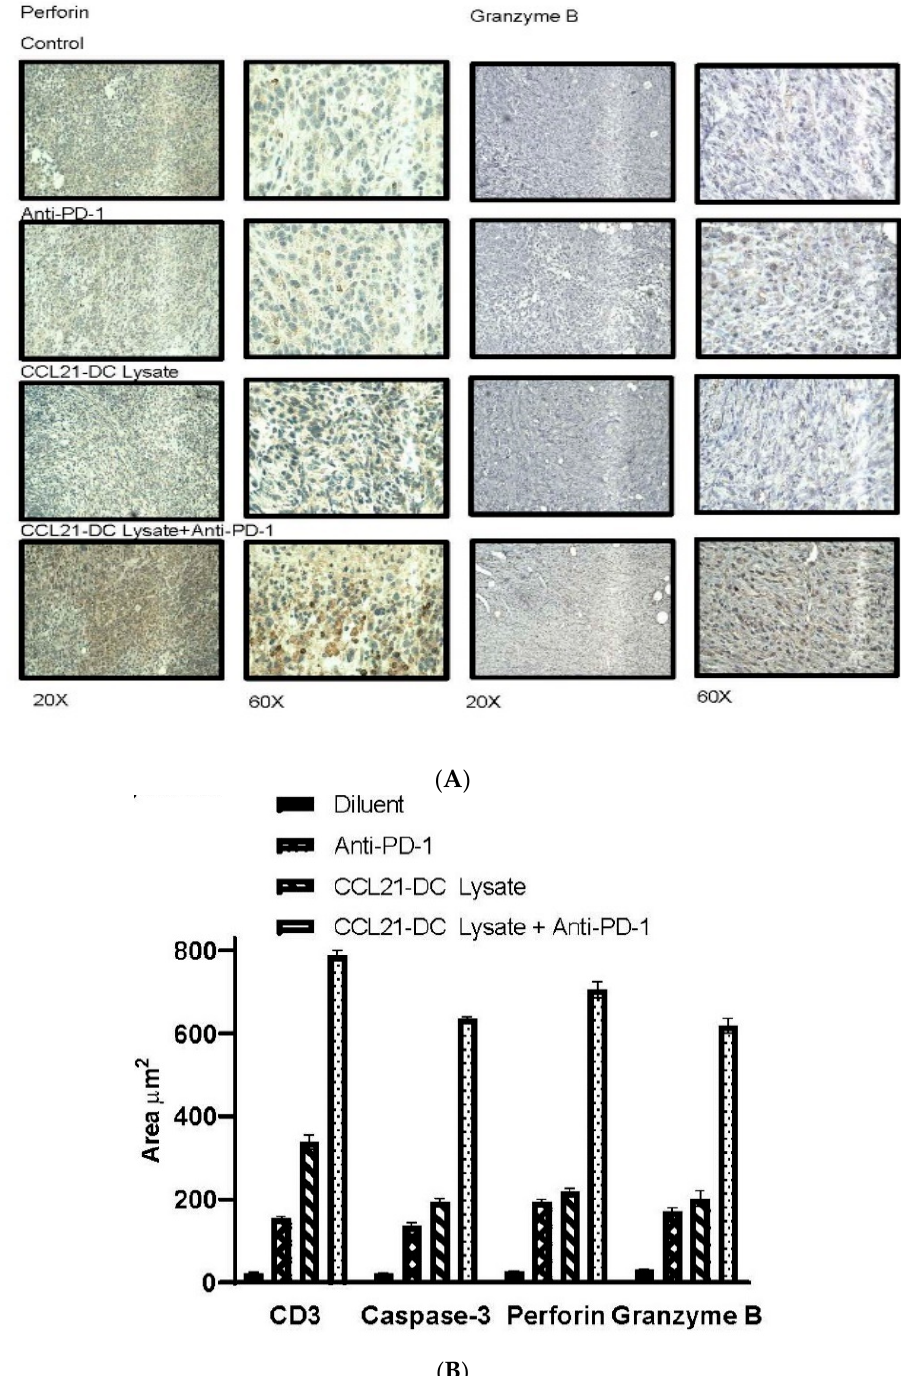
Figure 3. H&E revealed enhanced immune infiltrates and reduced tumor staining following combined therapy. ( A ) IHC of tumor sections revealed enhanced (i) CD3 T cell staining (brown), (ii) tumor cell apoptosis (brown), (iii) perforin, (iv) and granzyme B staining (brown) following combined therapy. ( B ) Stained areas of tumors were quantified by microscopy of IHC-stained paraffin-embedded sections. Anti-PD-1 plus CCL21-DC lysate vaccine treatment led to the highest levels of CD3 T cells, perforin, and granzyme B and greatest reduction in tumor burden, as denoted by enhanced caspase-3-stained apoptotic tumor cells compared with diluent control and monotherapy. Bars represent SE; p < 0.01 compared with diluent-treated control; p < 0.05 compared with monotherapy. Results are representative of a single experiment ( n = 4 mice/group).